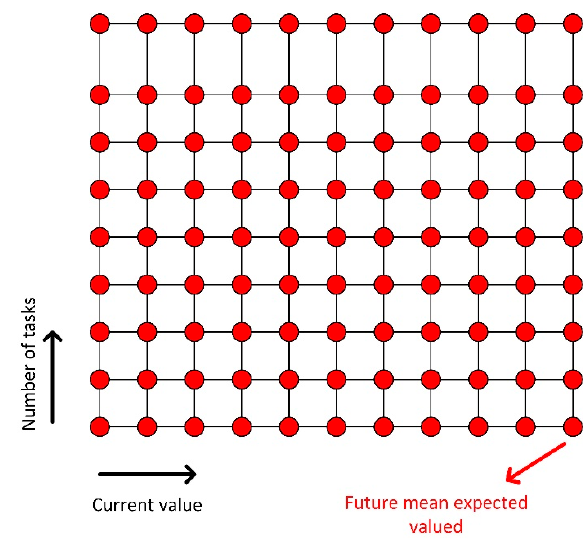
Figure 3. Grid for future wellbiciency